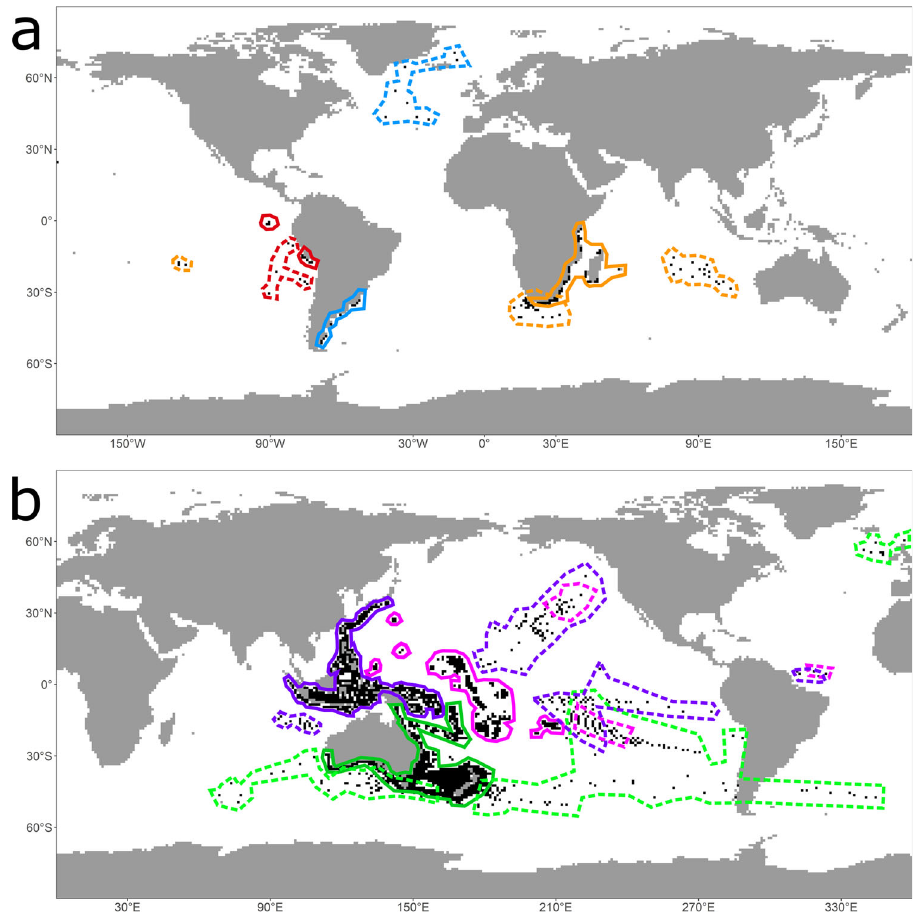
Fig. 5 Key biodiversity hotspots and their thermal analogs. Black pixels are either part of a hotspot or future analogs for a hotspot pixel. Solid lines enclose the hotspot pixels in the present, while the dashed lines enclose the hotspot ’ s future analogs. Each hotspot, along with its analogs is presented with a different color. In a the three hotspots identi fi ed in South America and Africa. In b , the three hotspots in East Asia and Oceania, with East-degrees projection to aid